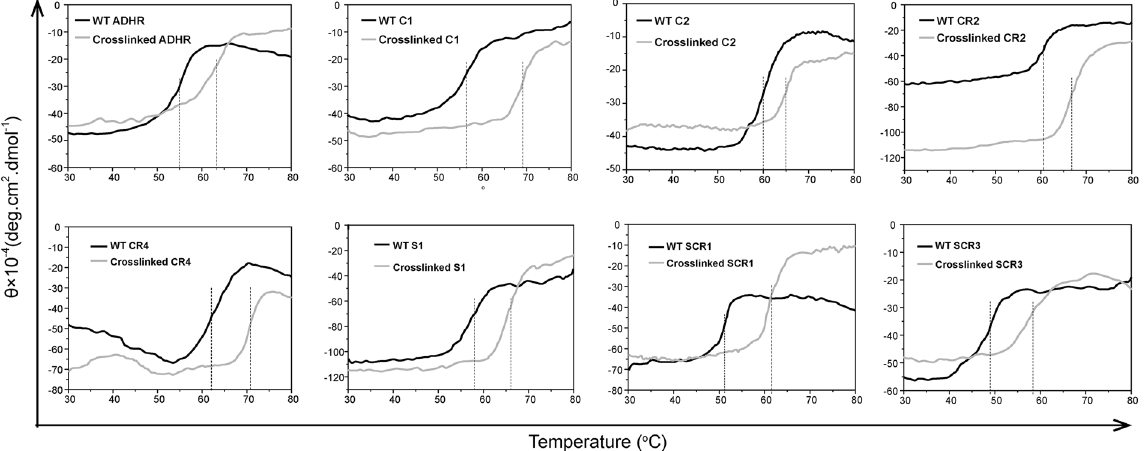
Figure 8. Thermal shift curves of 8 oxidoreductases and their crosslinked oxidoreductases. The buffer (5 mM phosphate buffer pH7.0, 0.1 mg/mL enzymes.) showed pH shift with no more than 0.5 while it was heated from 20 °C to 100 °C.